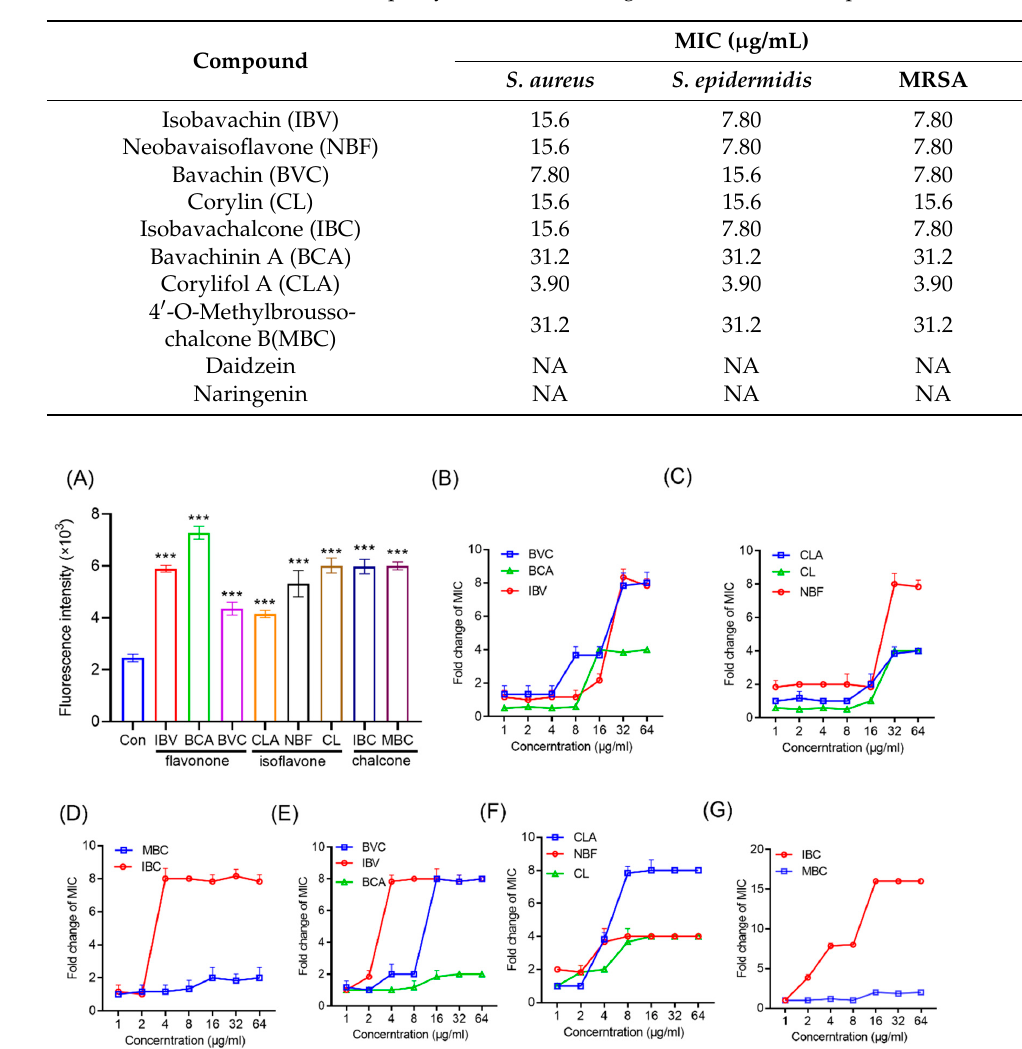
Figure 4. The IPFs in PCSs show robust antibacterial activity against MRSA. ( A ) Increased membrane permeability after treatment of IPFs in PCSs. ( B – G ) Exogenous addition of phosphatidylglycerol (PG) and cardiolipin (CL) abolished the antibacterial activity of flavonone ( B , E ), isoflavone ( C , F ), and chalcone ( D , G ) against MRSA. The concentrations of phospholipids were in the range of 1 to 64 µ g mL − 1 . Values are presented as the mean ± SD. p < 0.05 was considered statistically significant, *** p < 0.01 vs. the control (Con) group.